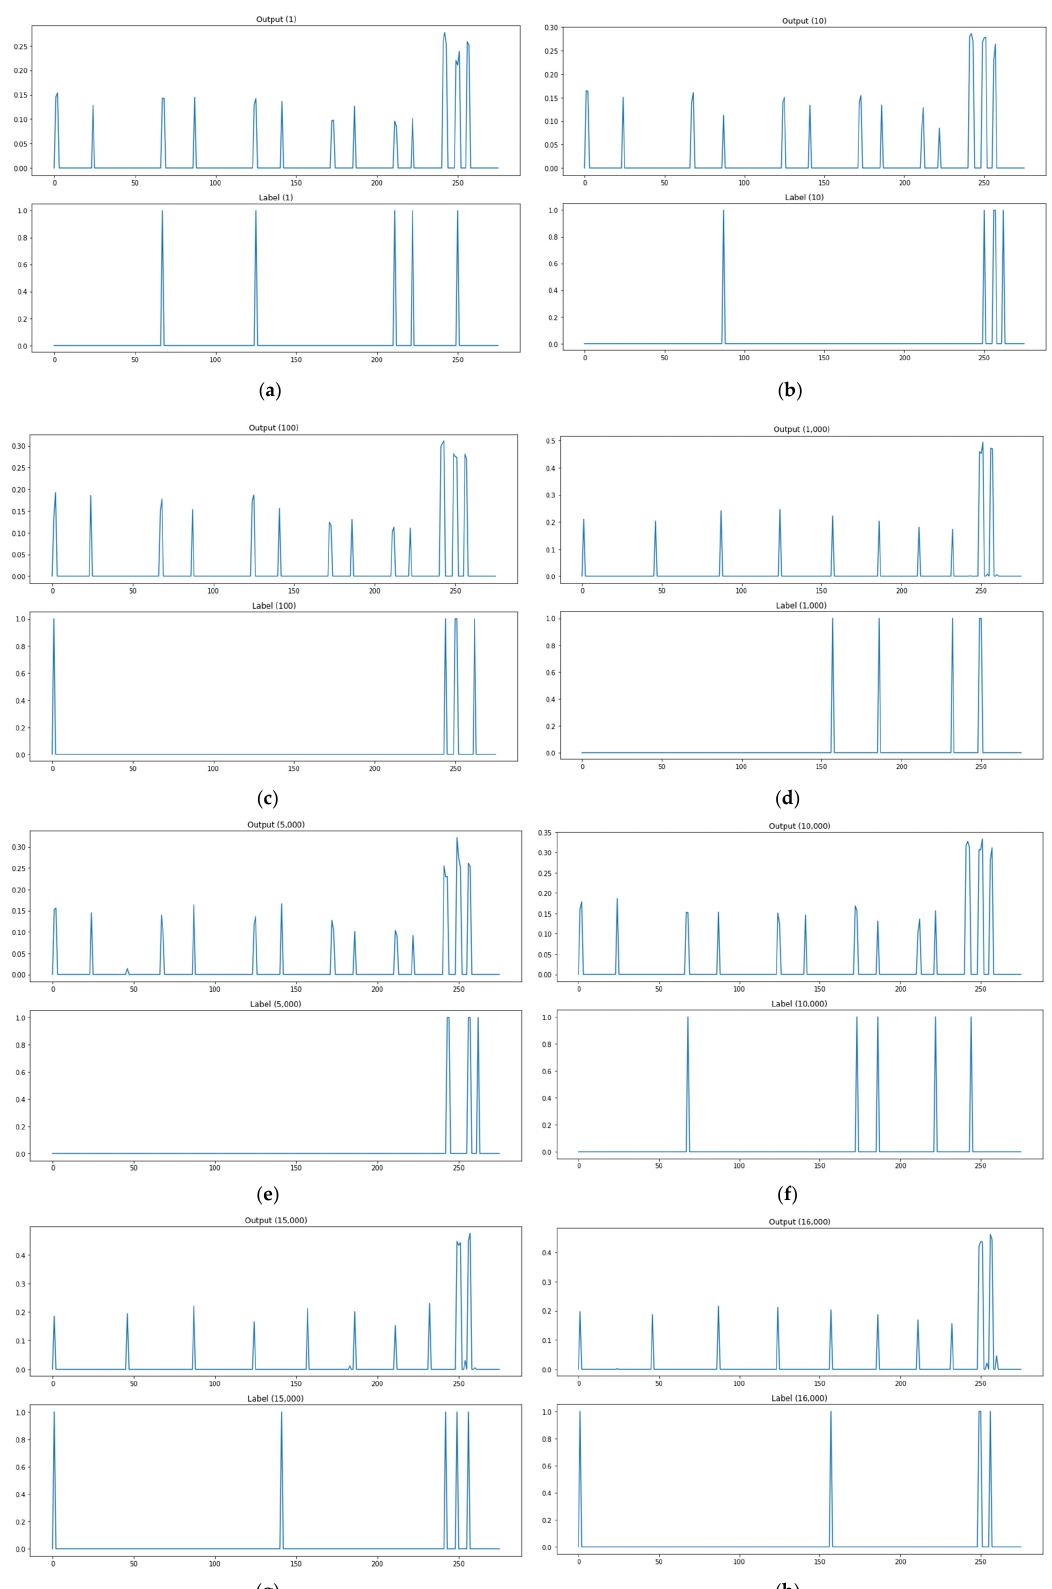
Figure 13. The outputs of the ANN and deep learning—output layer with Softmax (model 2). ( a ) Test data 1. ( b ) Test data 10. ( c ) Path test data 100. ( d ) Path test data 1000. ( e ) Path test data 5000.